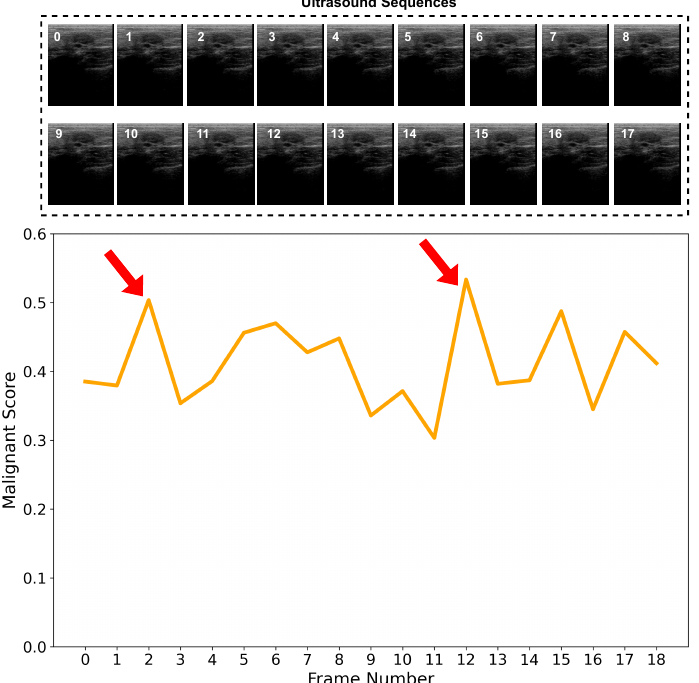
Figure 5. Malignancy score of each frame in a BUS sequence of a benign case. Arrows indicate malignancy scores higher than